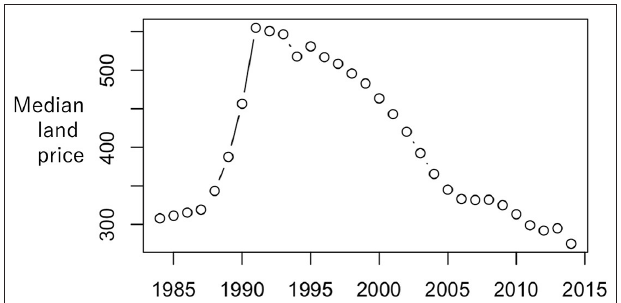
FIGURE 1 | Median residential land price per area (1976–2014).